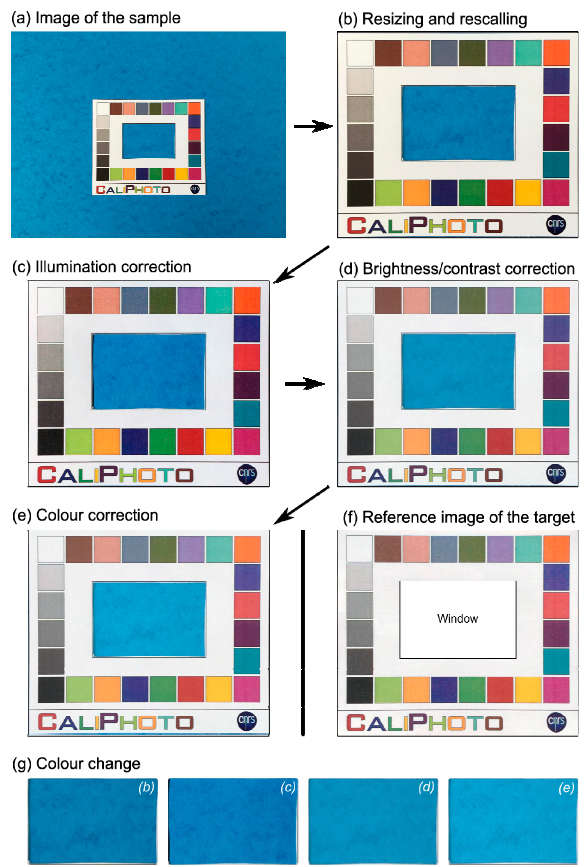
Figure 3. CaliPhoto correction process for sample images. ( a ) iPad photograph of the sample (blue paper) placed below the same Caliphoto colour plate as used to create the reference image in Figure 2. ( b ) Resized and rescaled image. ( c ) Image after removing the illumination plane. ( d ) Image after brightness and contrast correction. ( e ) Final reference image of the sample after colour calibration using the reference image of the colour plate (Figure 2d). ( f ) Reference image of the colour plate used for correction, shown for comparison. ( g ) Colour change of the sample area during the process from images ( b – e ).